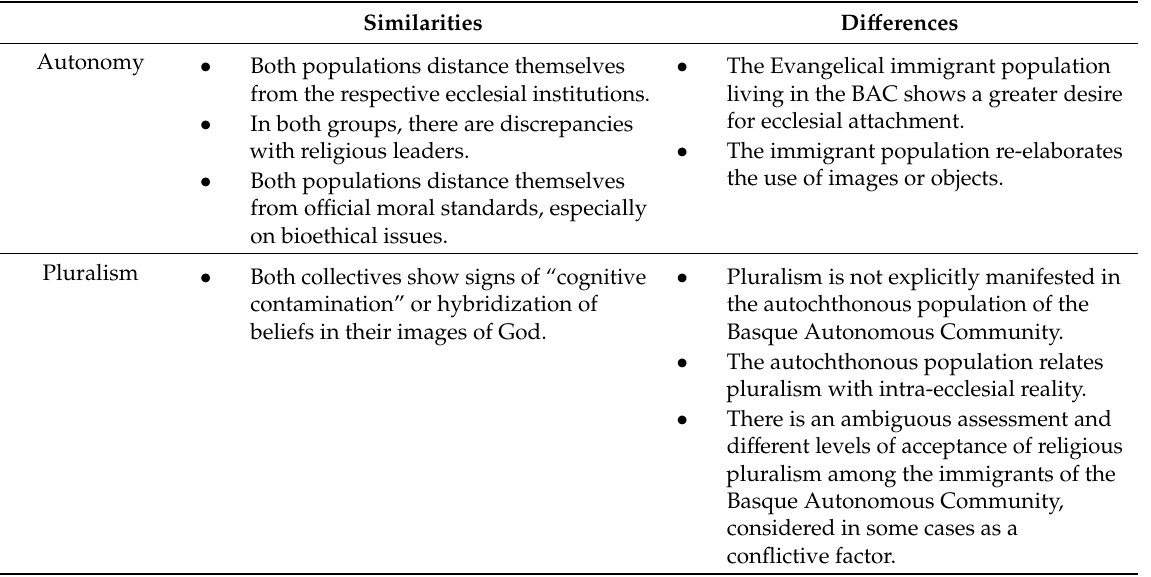
Table 7. Summary. Comparison between the Latin American immigrant population and the indigenous population of the